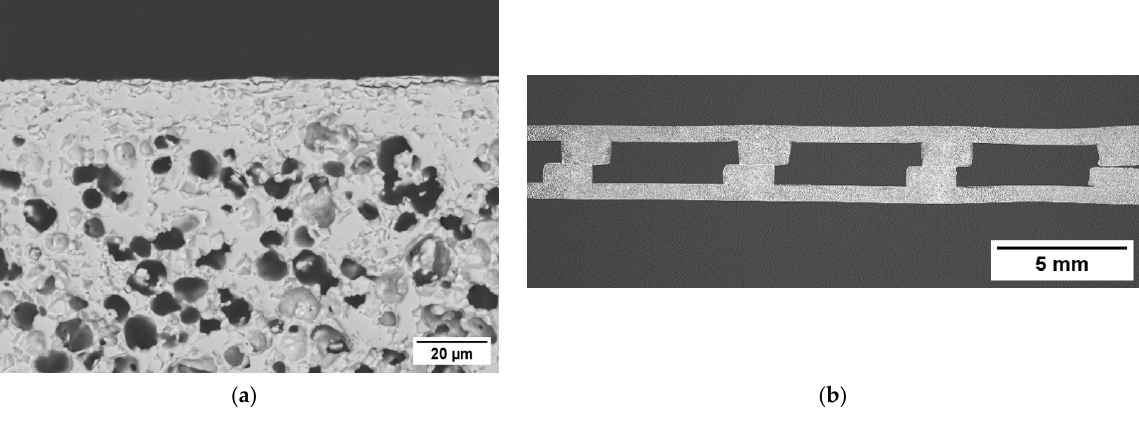
Figure 8. ( a ) Detail of the dense membrane layer and the underlying porous support. ( b ) SEM cross-section image of the membrane component.